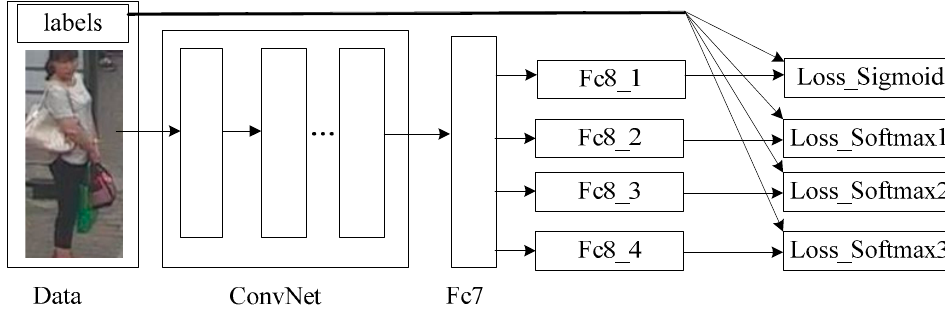
Figure 3. The proposed attributes recognition network model.